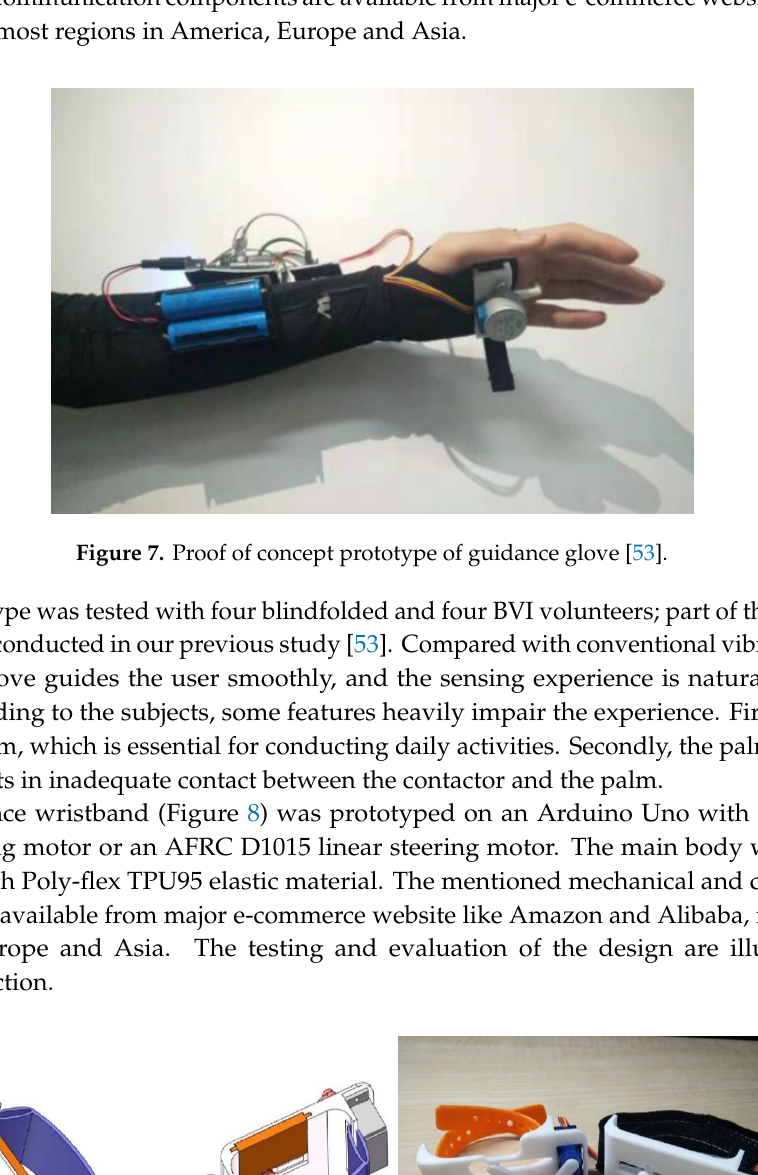
Figure 6. The design concept of the guidance wristband.